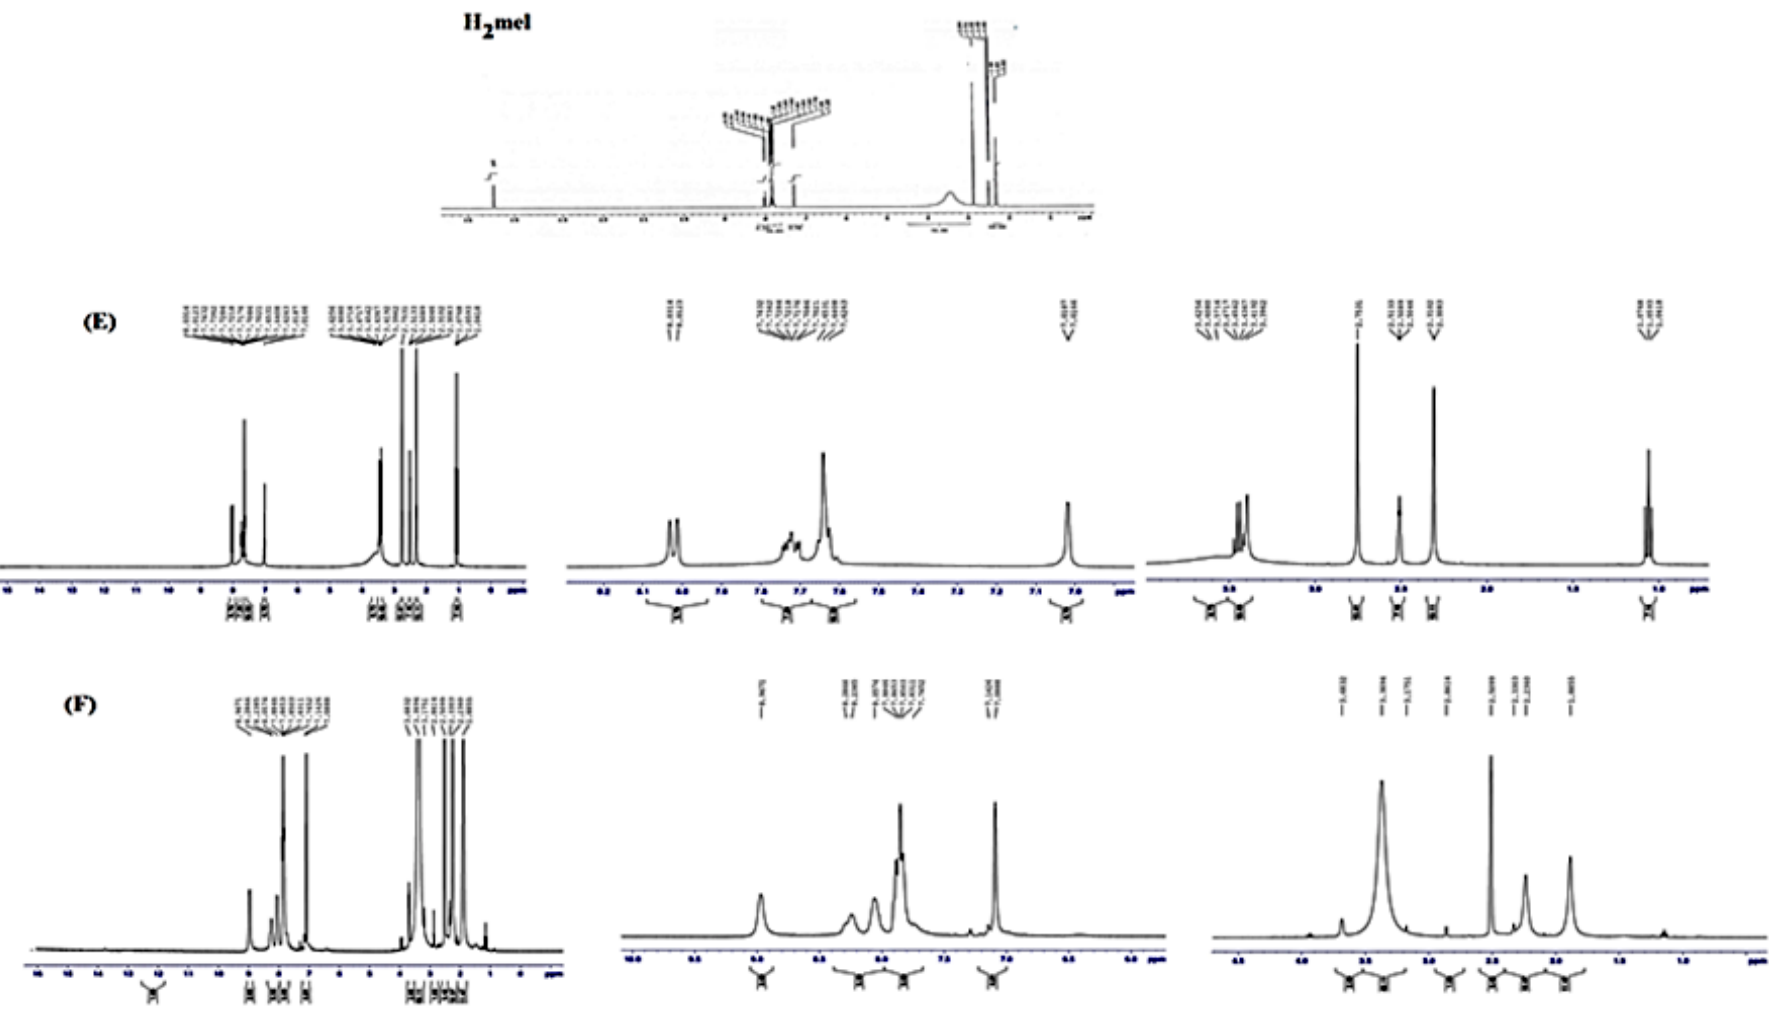
Figure Figure 2. 1 H NMR-DMSO- d 6 spectra for H 2 mel, ( E) and ( F ) compounds. where ( E) = Zn(II) complex and ( F) = Zr(IV) complex.